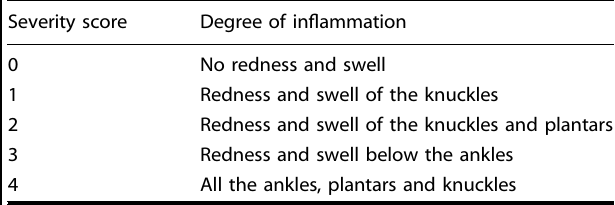
Table 3. The scoring criteria of arthritis